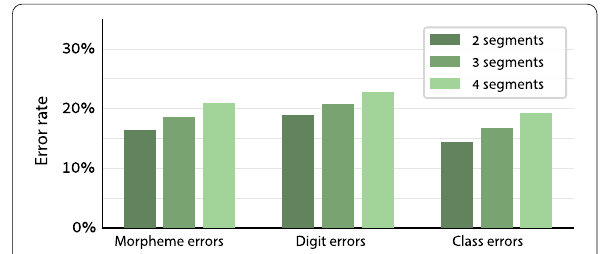
Fig. 5 Experiment 2 results: the morpheme, digit, and class error rate in each condition. Error rates were lower in the conditions with fewer, longer segments, which allowed for more syntax-based